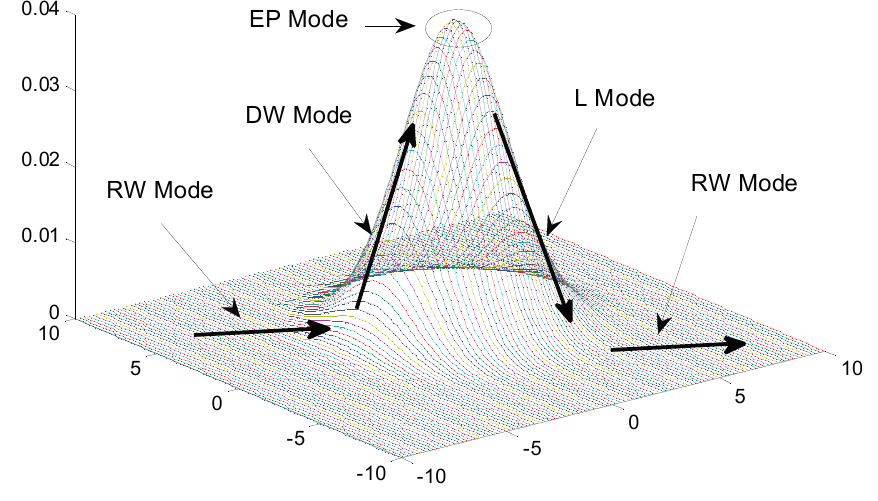
Figure 3. The “mountain” the data and DWTQ